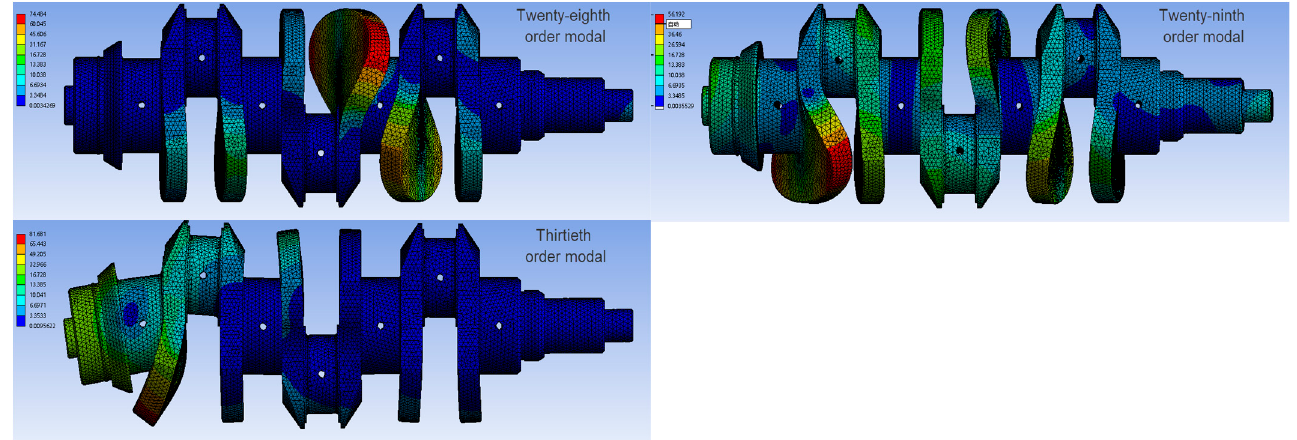
Figure 8. Tenth to thirtieth order modal vibration diagram.